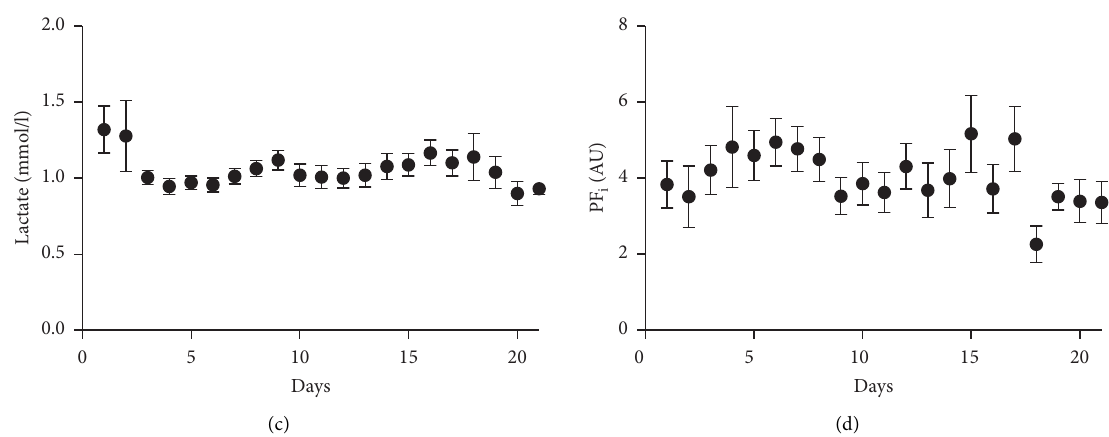
Figure 2: Circulatory characteristics (II) of COVID-19 patients. CVP: central venous pressure; PF